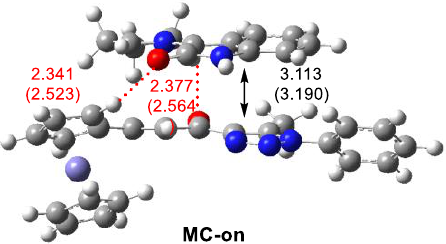
Figure 4. ω B97X-D/6-311G(d,p) optimized geometry of MC-on . Distances are given in angstroms, Å. Distances in methanol are given in parentheses. HB distances are given in red.